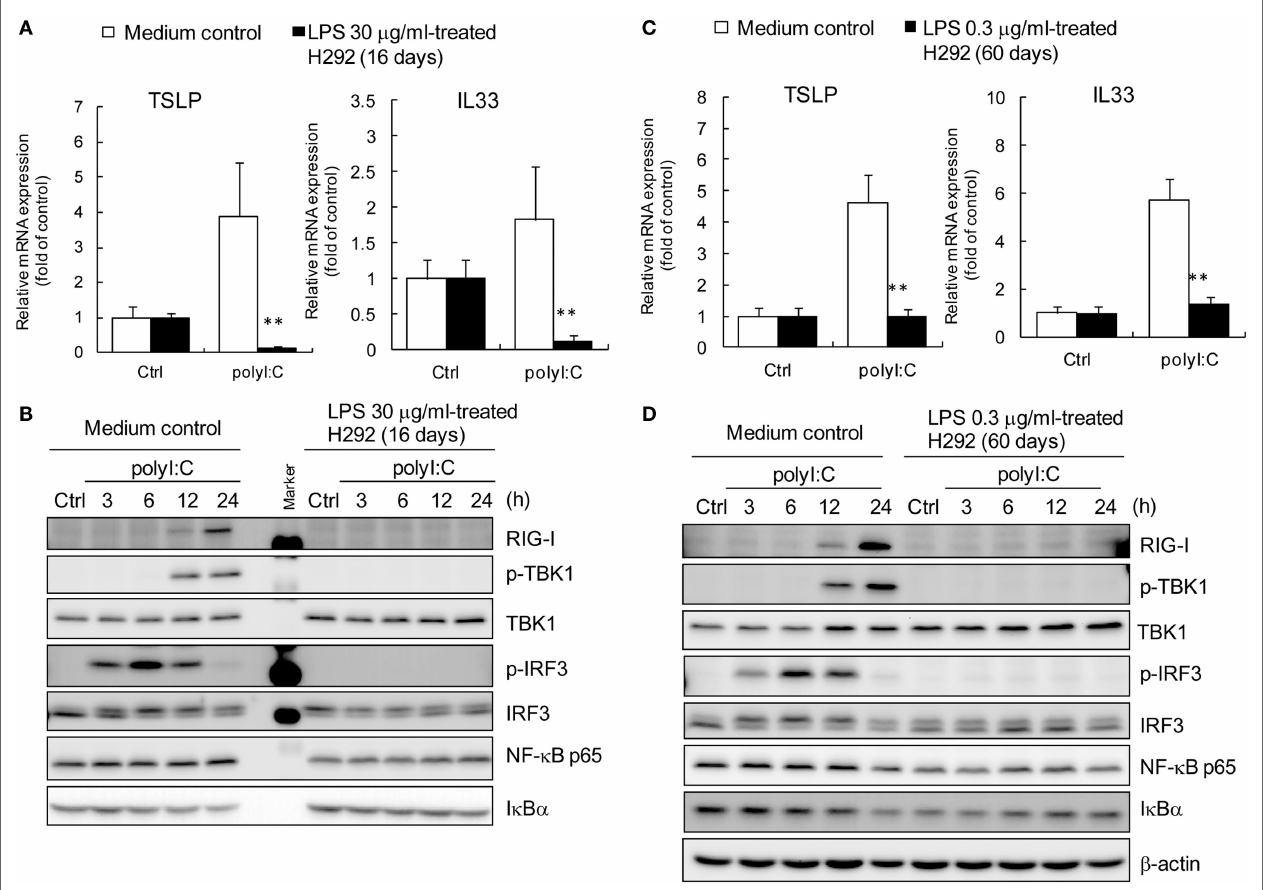
FigUre 7 | Defective activation of rig-i-irF3 signaling axis in h292 cells with long-term lPs treatment . LPS-trained H292 cells were established by long-term treatment of high level LPS (30 μ g/ml) and low-level LPS (0.3 μ g/ml) for 16 days (a) and 60 days (c) , respectively. RT-qPCR analysis of mRNA levels of polyI:C-induced TSLP and IL-33 are shown. The growth medium cultured cells were as the untreated control group. Data are mean ± SD from three independent experiments. ** P < 0.01 compared to control. (B,D) The whole cell extracts from high level and low-level LPS-trained or untrained H292 cells were harvested at 3, 6, 12, and 24 h after polyI:C stimulation. Immunoblotting analysis was performed with the indicated antibodies. Results are representative of three independent